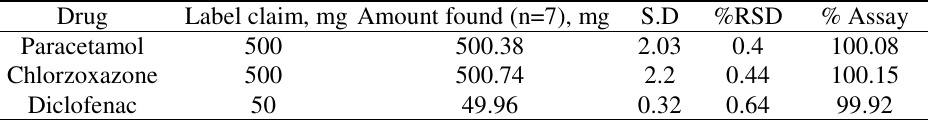
Table 3. Results of assay